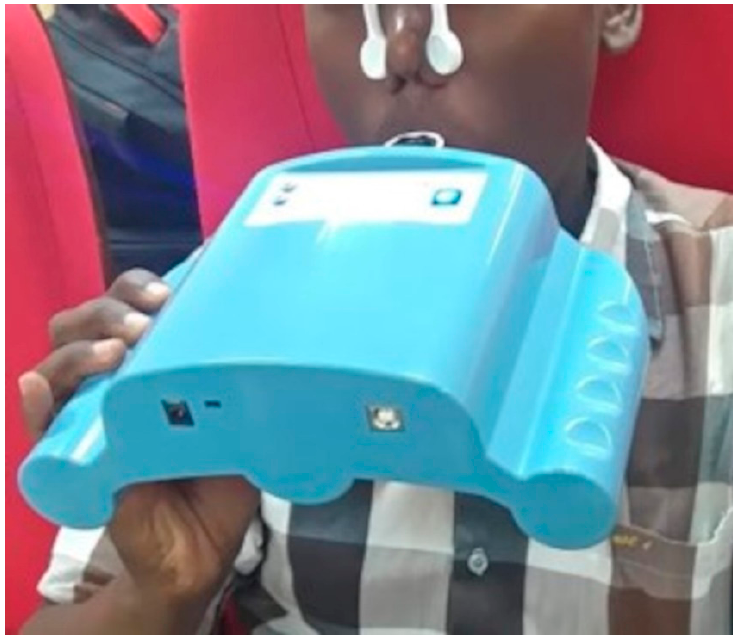
Figure 1. Taking a measurement from a patient using Aeonose device.